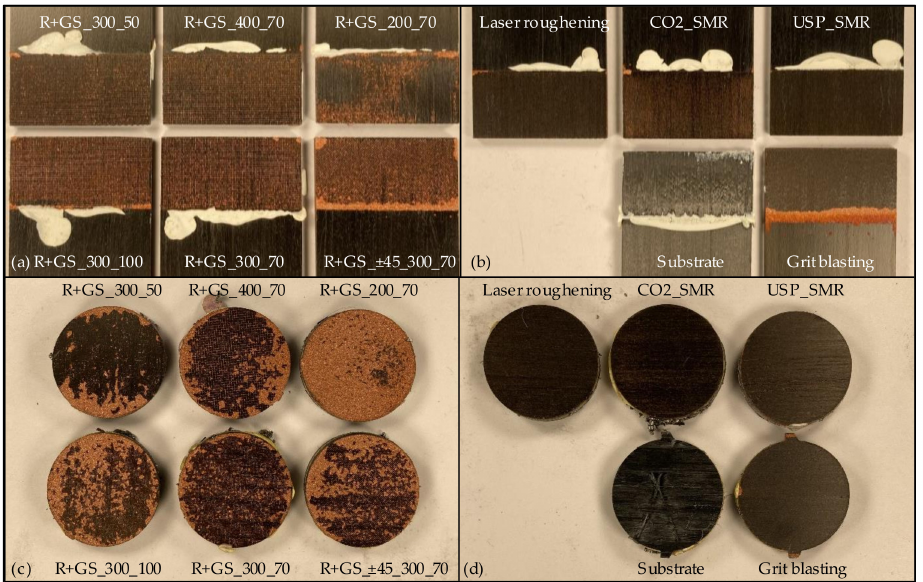
Figure 11. Fracture surfaces of wire arc copper coated CFRP substrates illustrating the different failure patterns after shear tensile test ( a , b ) and pull-off test ( c , d